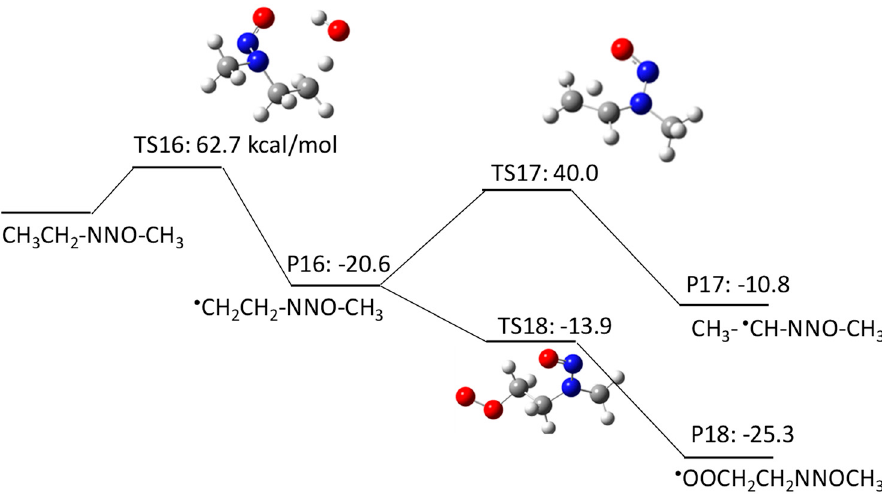
Figure 5. Free energy profile for pathway 2–2 of the HO • -induced reaction pathways for NMEA via H abstraction from a C–H bond of the terminal CH 3 functional group in the ethyl chain. The numbers (kcal/mol) are the free energy of activation for the TS and free energy of reaction for the P relative to the corresponding reactant.